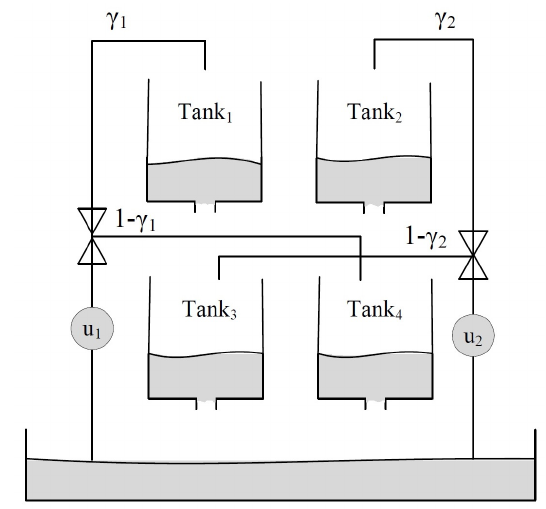
Figure 3: A sketch of the quadruple tank